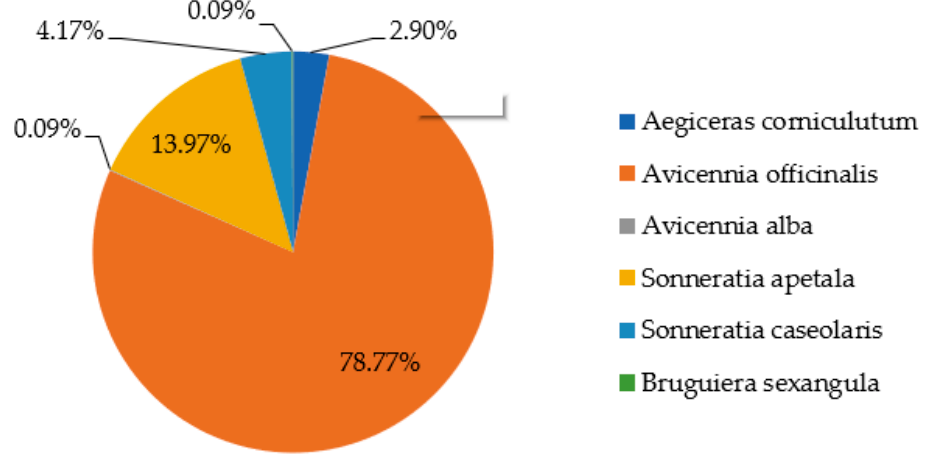
Figure 2. Species Distribution of Mangrove stands in LetKhutKon Village. Densities of mangroves in the 1-ha sample area ranged from 550 to 2025 trees per ha (mean 1102 ± 353 stems ha − 1 ); a total basal area of the stand was 745.95 m 2 ha − 1 (mean ± sd = 29.84 ± 14.03 m 2 ha − 1 ) and varied from 4.93 m 2 ha − 1 to 69.13 m 2 ha − 1 . The highest number of trees was found in plot 18 (81 individuals) followed by plot 16 (75 individuals), plot 9 (65 individuals), and plot 14 (61 individuals 61). The lowest number of trees was found in plot 24 (22 individuals) and plot 22 had the most abundant species (five species) as shown in Figure 3. The DBH of individual trees varied between 5 cm and 41.3 cm, with total height ranging from 1.5 m to 9.75 m, with an average of 16.64 ± 8.23 cm and 5.71 ± 1.90 m. About 50% of the tree diameters and heights were between 10–21.98 cm and 4.267–7.315 m, respectively. Among the six mangrove species generally found at the study site, A. officinalis was found to have the maximum DBH (15.80 ± 3.47 cm) and height (5.70 ± 0.85 m). The lowest height and DBH were recorded in Aegiceras corniculutum with 12.19 ± 1.83 cm and 3.52 ± 0.61 m respectively. Additionally, Figure 4 described Height–Diameter scatter plot of mangroves at the study site. The functional relationship between height and diameter of a tree was effectively described by a log function. Tree height was positively correlated with diameter of the mangrove stand and the coefficient of determination (R 2 ) was 0.61.